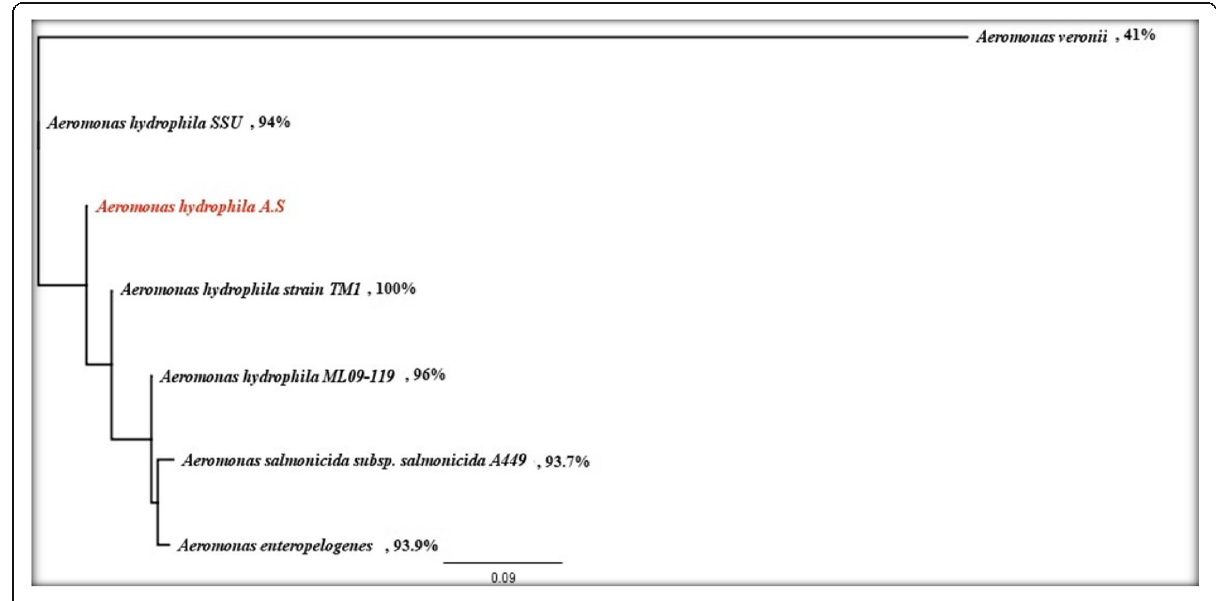
Fig. 2 Rooted phylogenetic tree of 16S rRNA gene of isolate